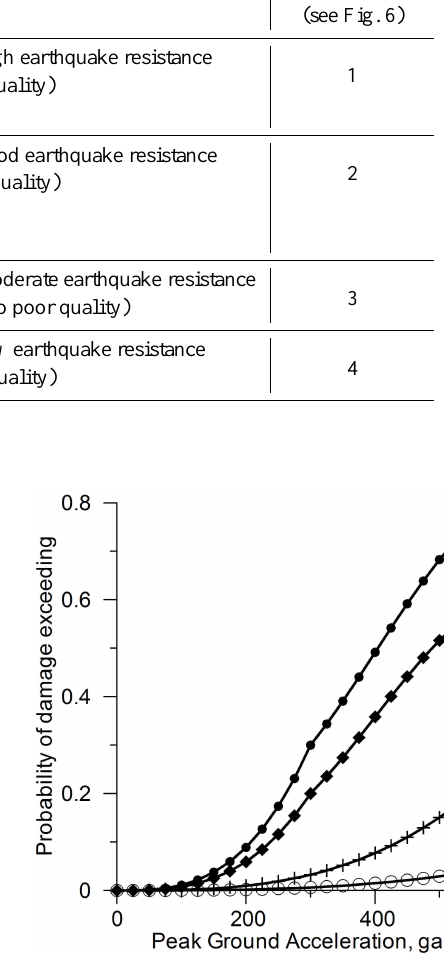
Fig. 6. Theoretical fragility curves for four types of building con- structions. The curve index i marks building type i ( i =1, 2, 3,